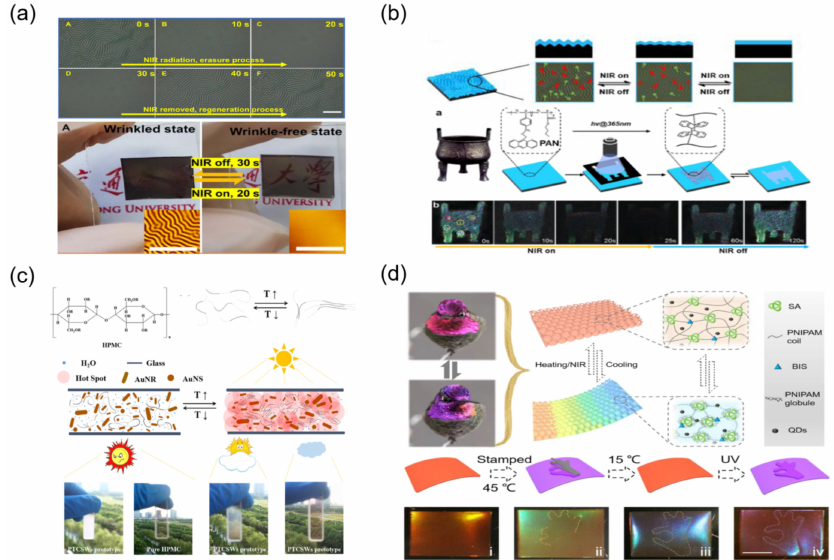
Figure 8. The approaches for optical driving mechanoresponsive smart windows: ( a , b ) based on the high photothermal conversion efficiency of CNT [49,50] Copyright 2018, American Association Advancement Science (Washington, DC, USA) and 2020, American Chemical Society, ( c ) based on metal nanoparticles [51] Copyright 2018, John Wiley and Sons, ( d ) based on inverse opal scaffold structure [52] Copright 2022,